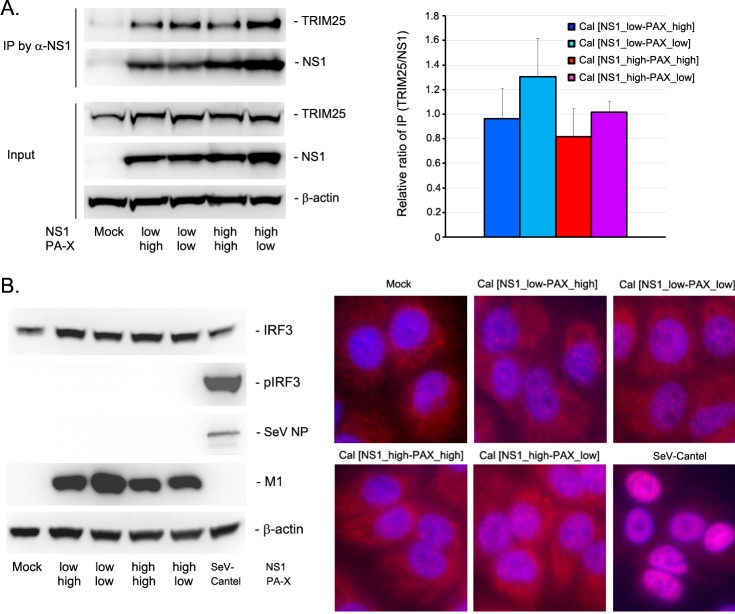
Inhibitory activity of NS1 on innate signaling.(A) Interaction between NS1 and TRIM25 was determined by co-immunoprecipitation assay. Infected cell lysates were reacted with anti-NS1 antibody, and the immunoprecipitated materials were analyzed for the presence of TRIM25 and NS1. Left figure is a representative of four independent experiments and bar graph on right shows relative ratio of co-immunoprecipitated proteins (n = 4). (B) Activation of IRF3 in infected cells. (Left) A549 cells infected with the viruses were determined for IRF phosphorylation by Western blot analysis. (Right) Translocation of IRF3 to the nucleus in infected cells was determined by immunofluorescence assay using anti-IRF3 antibody (red) counterstained with DAPI (blue).